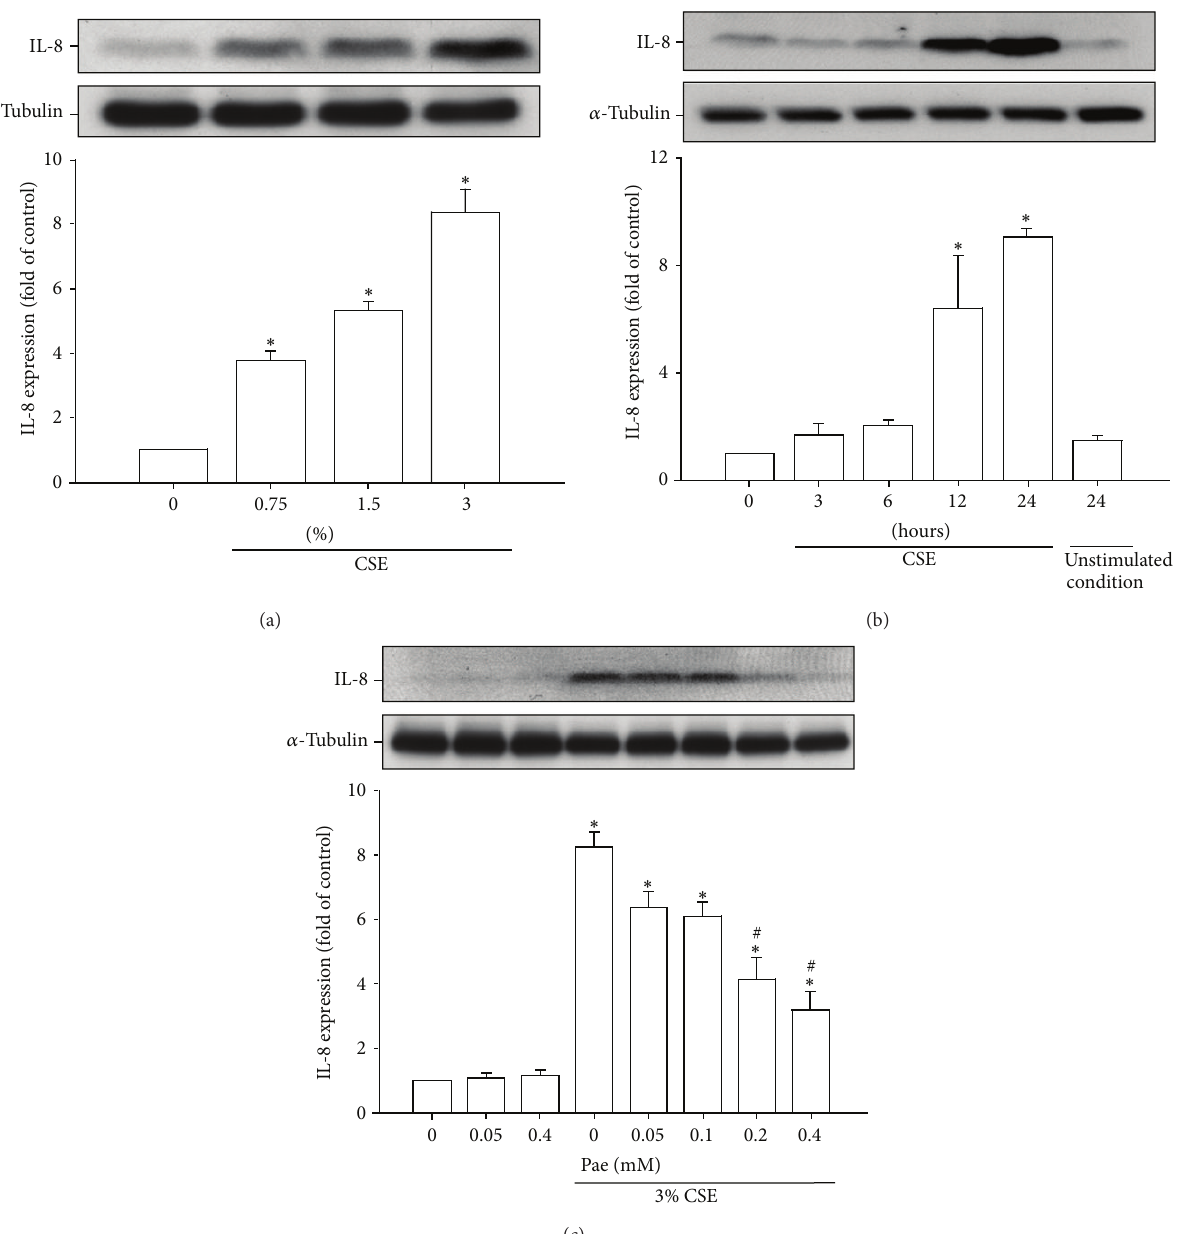
Figure 5: Paeonol (Pae) dose-dependently attenuates the induction of IL-8 by cigarette smoke extract (CSE) in human bronchial epithelial cells. (a) Cells were exposed to 0–3% CSE for 24 hours. (b) Cells were incubated with medium alone (control) or 3% CSE for indicated times. (c) Cells were incubated with medium alone or 3% CSE for 24 hours with pretreatment with various concentrations (0–0.4 mM) of Pae. Protein levels of IL-8 in the cell lysates were analyzed by Western blotting. Data in each group are mean ± SEM from four independent experiments. ∗ 𝑃 < 0.05 versus control ((a), (c)) or zero time (b). # 𝑃 < 0.05 versus CSE without Pae pretreatment